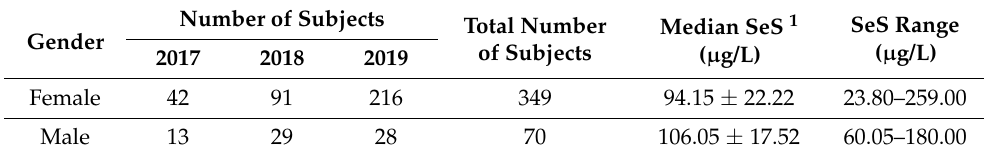
Table 2. Range and median SeS concentration of young subjects (16–35 years) from Western Romania by